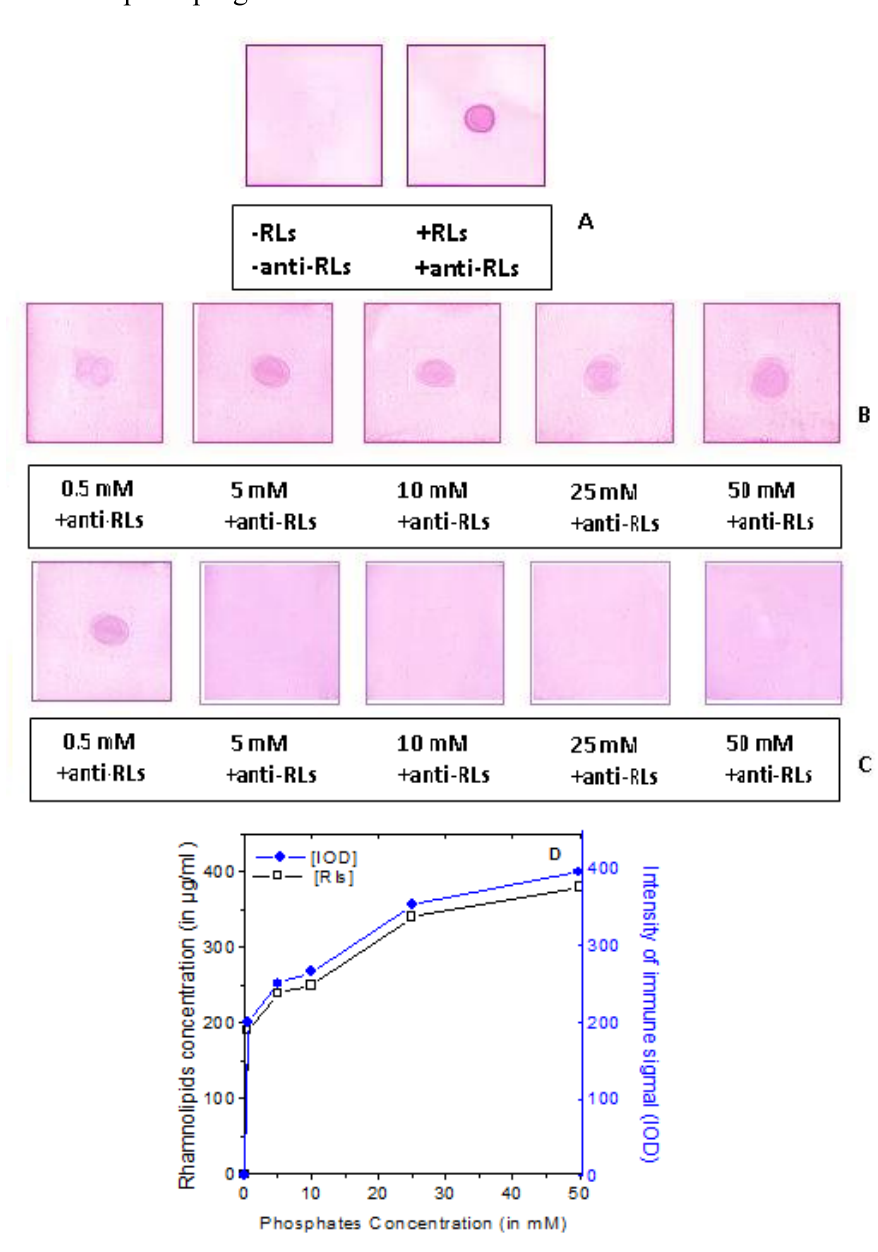
Figure 6. Immuno-dot blot assay performed as application for RLs detection in various samples using the anti- Tth RLs antibodies. ( A ) As a positive control purified Tth RLs were used as previously described (right panel, A), and as a negative control a sample without Tth RLs was used (left panel, A), which were spotted in nitrocellulose membranes. ( B ) Extracellular spent supernatants from T. thermophilus cultures grown for 70 h at 75 °C, and E. coli cultures grown for 24 h at 37 °C ( C ), in the presence of sodium gluconate as sole carbon source containing various concentrations of phosphates affecting Tth RLs production (from left to right 0.5, 5, 10, 25, and 50 mM of phosphates) were spotted. Then membranes were probed with 1/500 dilution of rabbit polyclonal antiserum against Tth RLs. ( D ) Comparative curves were obtained from the determination of RLs in various cultures using the colorimetric orcinol method, as well as from the quantitative image analysis of the Dot Blots membranes immune-stained with the anti-RLs antibody by the Gelpro Analyzer V.3 computer